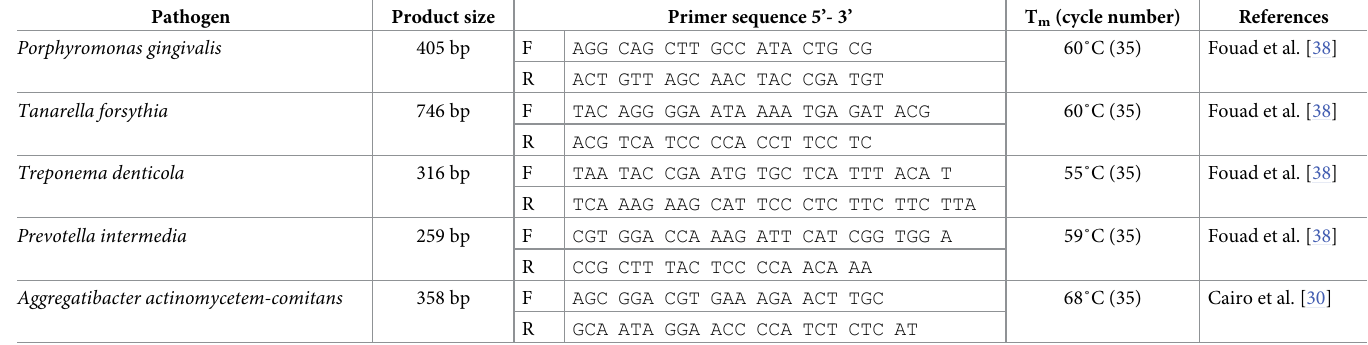
Table 3. Primer sequences. Primer sequences F–forward, R–reverse, PCR product size, annealing temperature (T m ), number of PCR cycles, reference source [30,